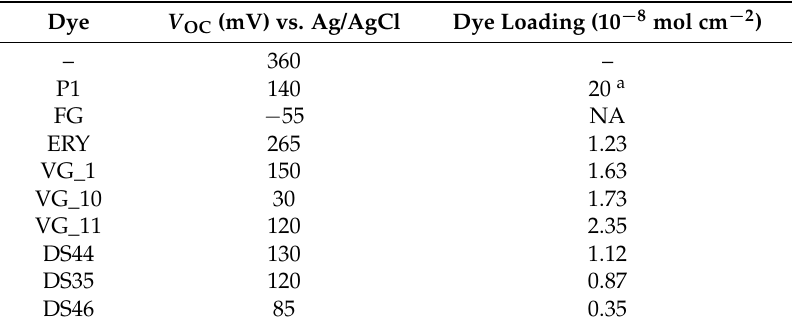
Table 1. Second column from left: list of open-circuit potential values V OC of the three-electrode cells differing for the nature of the sensitizer anchored on the NiO-working electrode. In the third column from left, the values of V OC,20 refer to the open-circuit value of the cell after electrochemical cycling. The number of consecutive electrochemical cycles was 20 ( vide infra ). The given value was recorded when the open-circuit potential was steady for at least 30 min after the conduction of 20 voltammetric cycles within the potential range − 0.3 V ≤ E appl ≤ 1.2 V vs. Ag/AgCl. The first column on the right lists the values of dye loading on the NiO film determined via the desorption method described in [90]. For the quantitative determination of dye loading in the case of the NiO sample sensitized with Fast Green (FG), the desorption method could not be adopted because of the scarce effect of dye desorption with the ordinary bleaching agents having medium basic